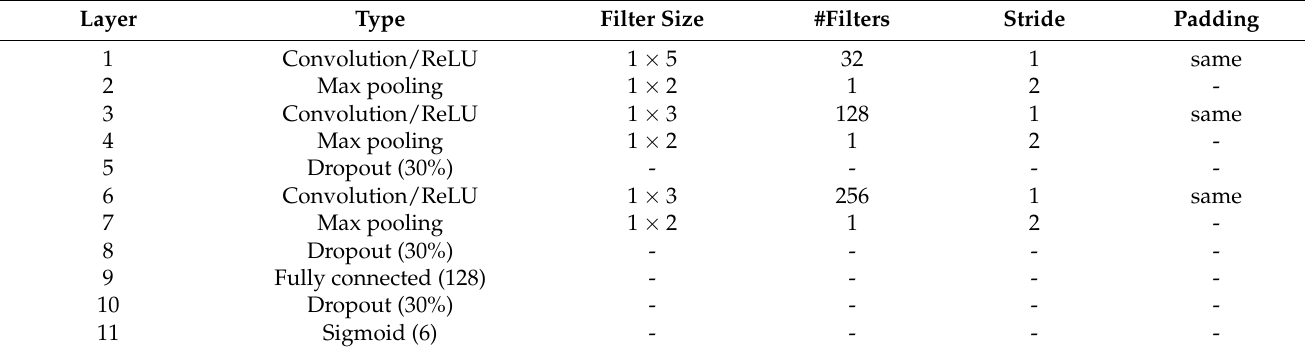
Table 3. Convolutional neural network architecture for experiment 2.